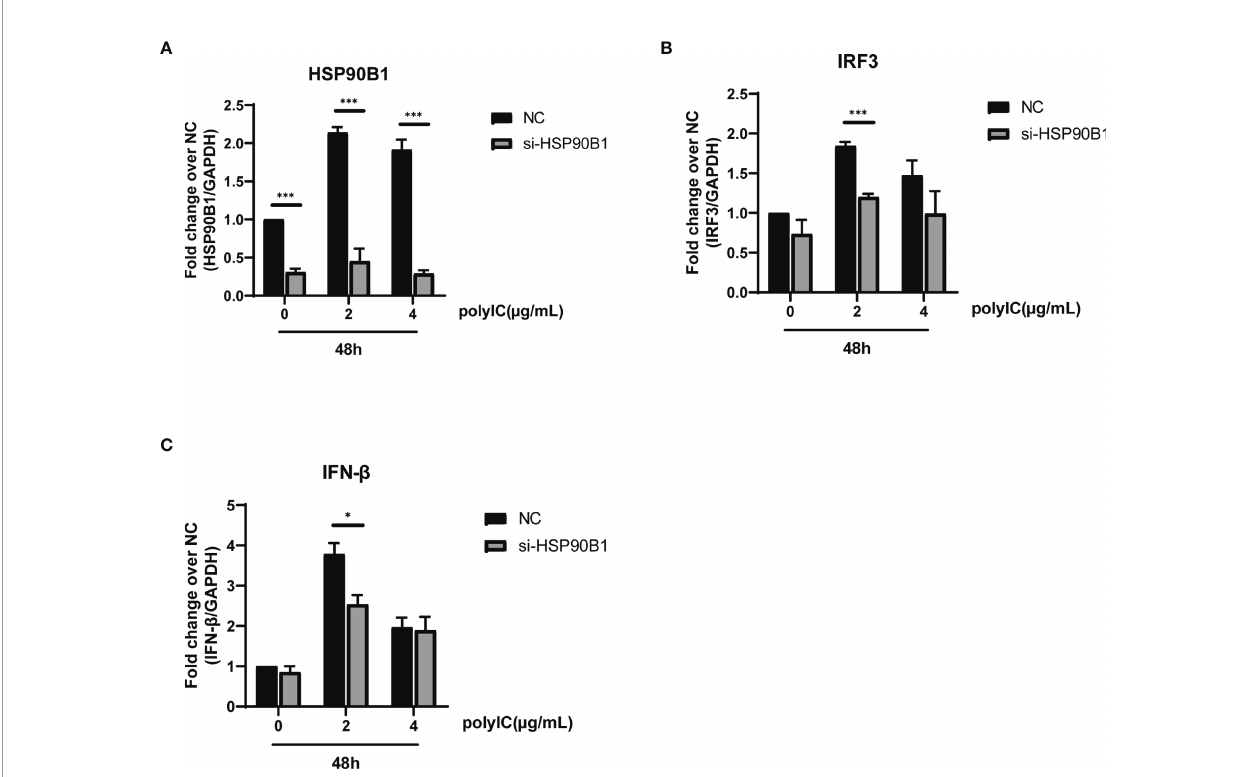
FIGURE 7 | Knockdown of HSP90B1 inhibits IFN pathways induced by poly(I:C). (A – C) HeLa cells were plated in 12-well plates and co-transfected with si-HSP90B1 and poly(I:C) at the indicated concentration. At 24 h post-transfection, mRNA of HSP90B1 and cytokines in IFN pathways were measured by RT-PCR. *P < 0.05; ***P < 0.001 versus empty vector (one-way ANOVA). Three independent biological replicates were analyzed, the results of one representative experiment are shown, and the error bars indicate the SD